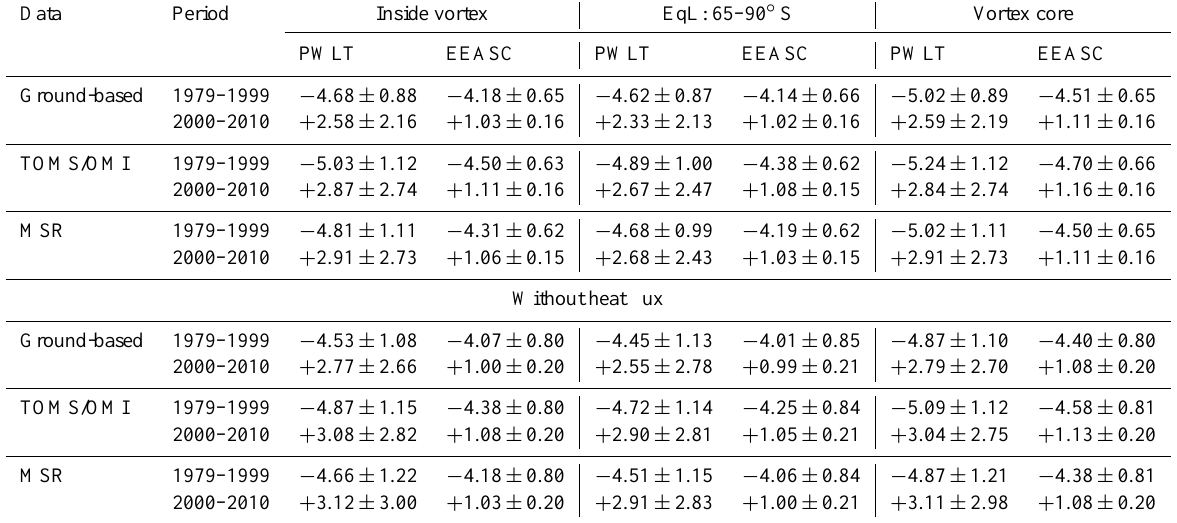
Table 3. Antarctic ozone trends in DUyr − 1 estimated from the deseasonalised September–November vortex averaged ground-based, TOMS/OMI, and MSR data using the PWLT (piecewise linear trend) and EEASC (equivalent effective Antarctic stratospheric chlorine) regressions. The regression results without considering heat flux are also shown in the bottom panel. The error values represent 95% confi- dence intervals. The results are shown for various vortex averaged calculations: inside vortex, over the equivalent latitudes (EqLs) 65–90 ◦ S and inside vortex